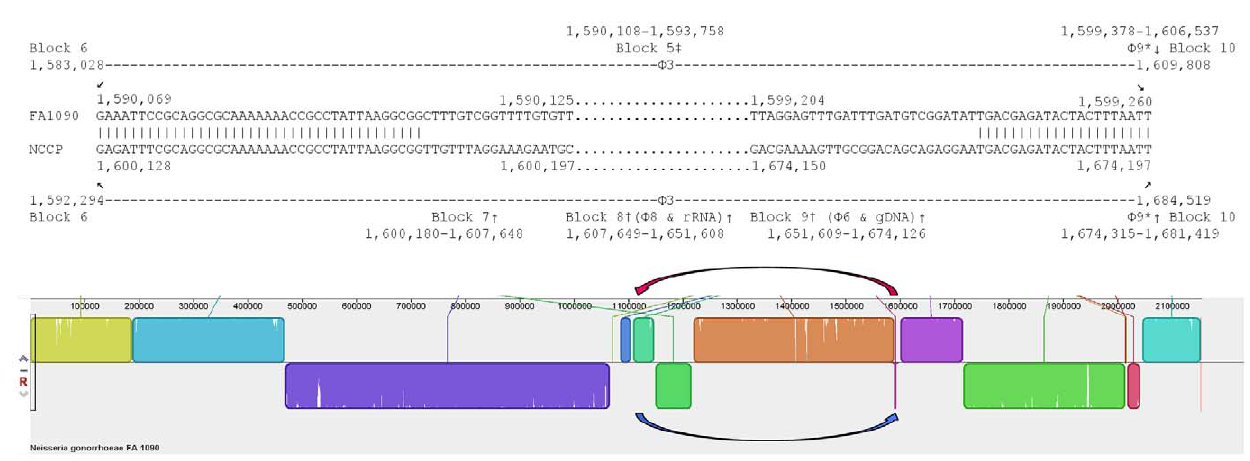
Figure 5. Model for the rearrangement of block 2. Block 2 (green) is present between block 1 (yellow) and block 3 (light blue) in N. gonorrhoeae strains NCCP11945 (shown) and TCDC-NG08107. In our model, this region of DNA has been deleted from this location in strain FA1090, making blocks 1 and 3 adjacent (Figure 1). This is shown at the single base level through alignment of sequence to the left and right of the block 2 sequence in strain NCCP11945 (top) with the contiguous sequence of blocks 1 and 3 in strain FA1090 (bottom). The block 2 region of DNA is located elsewhere in the strain FA1090 genome in an inverted orientation (Figure 1). Excision appears to have been via flanking IS1106 elements (Table S3), followed by ISNgo2 element mediated integration using the native ISNgo2 element in block 2 (green arrow; Table